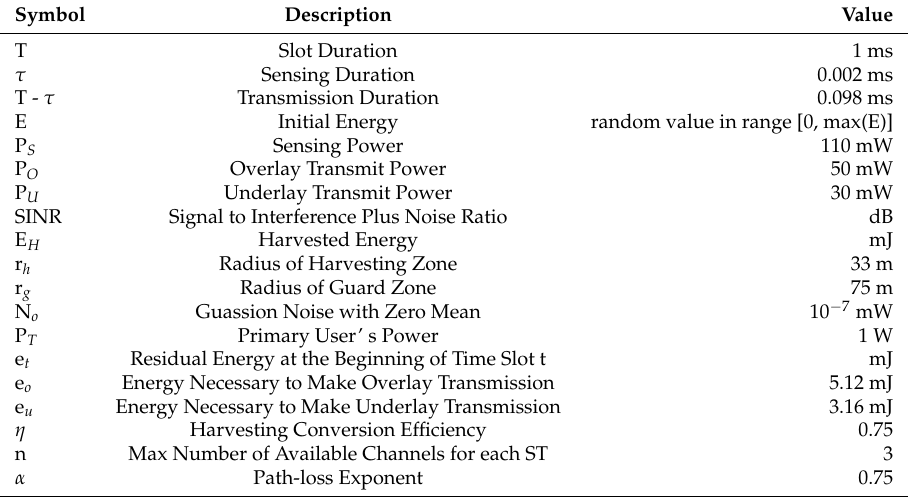
Table 4. Simulation